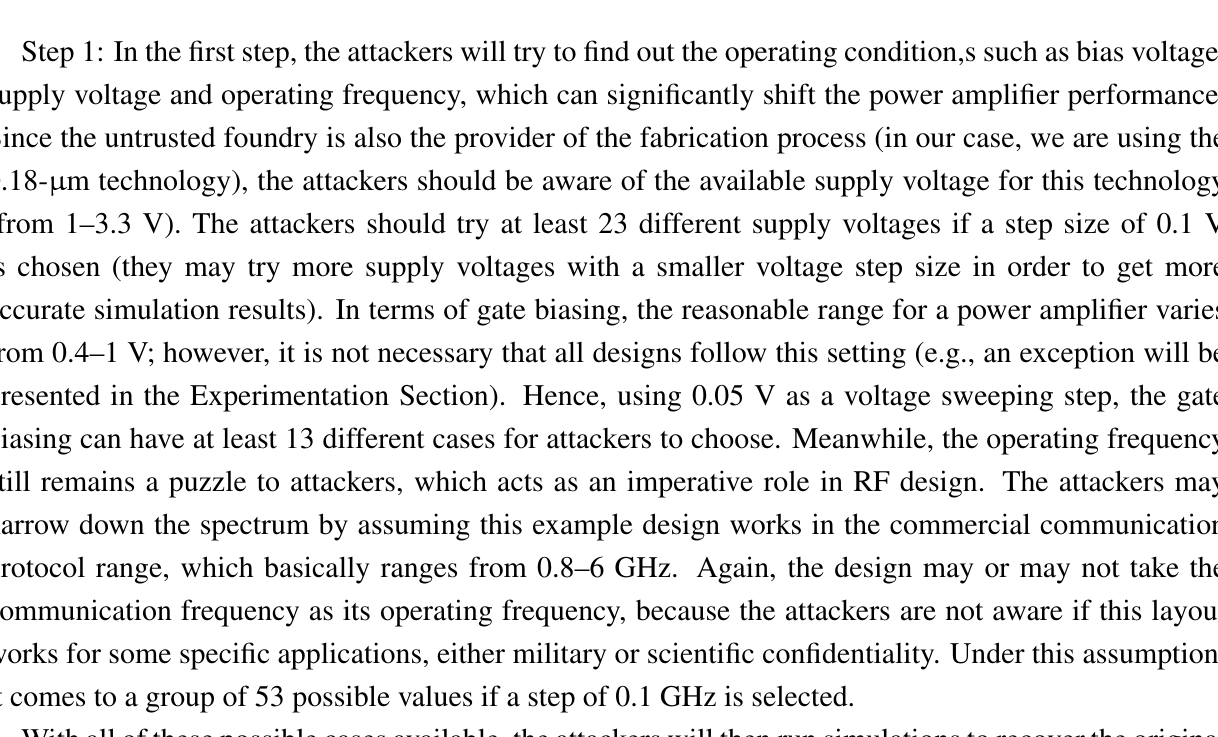
Figure 3. A Class AB power amplifier with metal6 removed (missing